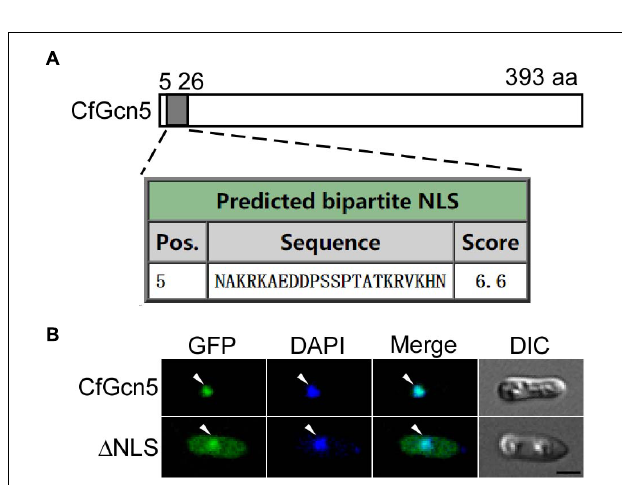
FIGURE 9 | The NLS contributes to the nuclear localization of CfGcn5. (A) The NLS prediction of CfGcn5 with the cNLS Mapper website. (B) The deleted NLS region of CfGcn5 ( (cid:49) NLS) showed cytoplasmic and nuclear localization. Arrowheads show the representative co-localized areas. Bar = 5 µ